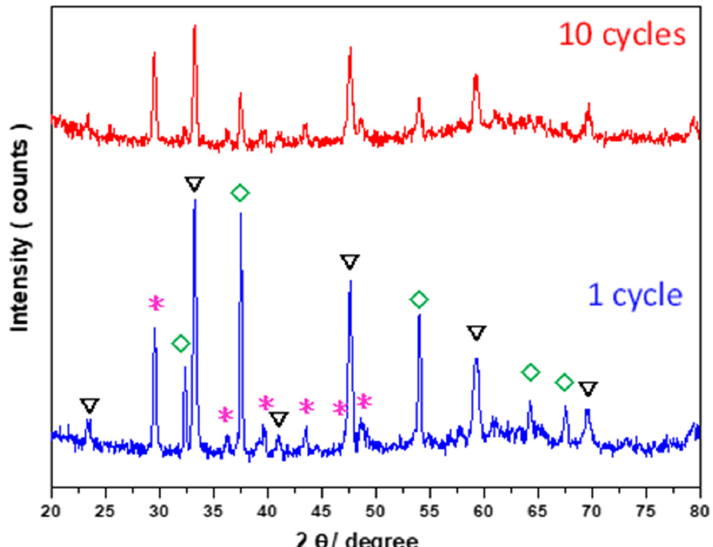
Figure 9. XRD results of ( a ) CaTi-3 and ( b ) CaTi-5 collected from after 1 cycle and 20 cycle experi- ments, where the inverted triangle symbol represents CaTiO 3 , the diamond symbol represents CaO, and the star symbol represents CaCO 3 .